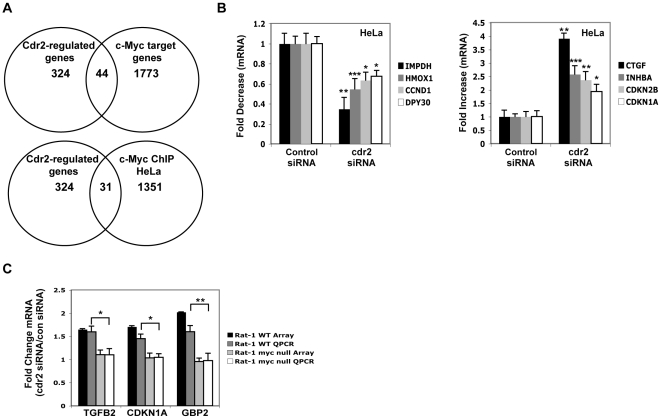
Cdr2 knockdown causes mis-regulation of endogenous c-myc target genes.A. Venn diagrams of microarray data of control and cdr2 siRNA-treated HeLa cells that recently exited mitosis. Upper, 44 genes overlap between 324 cdr2-regulated genes and 1773 c-myc target genes; lower, 32 genes overlap between cdr2-regulated genes and 1351 c-myc ChIP HeLa targets. B. qRT-PCR of select cdr2-regulated c-myc target genes that are decreased (left) and increased (right) following cdr2 knockdown (see Table 1); *p<0.05, **p<0.005, ***p<0.0001. C. Microarray and qRT-PCR analyses of three cdr2-regulated c-myc target mRNAs in wild type and c-myc null Rat-1 cells; *p<0.05, **p<0.005.